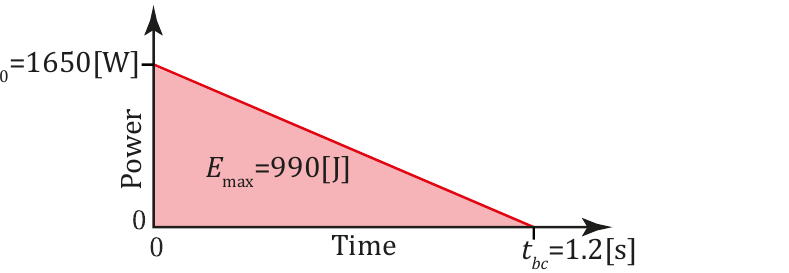
Figure 14. Triangular power profile of a regenerative charging cycle. The stored energy is represented by the the red area.